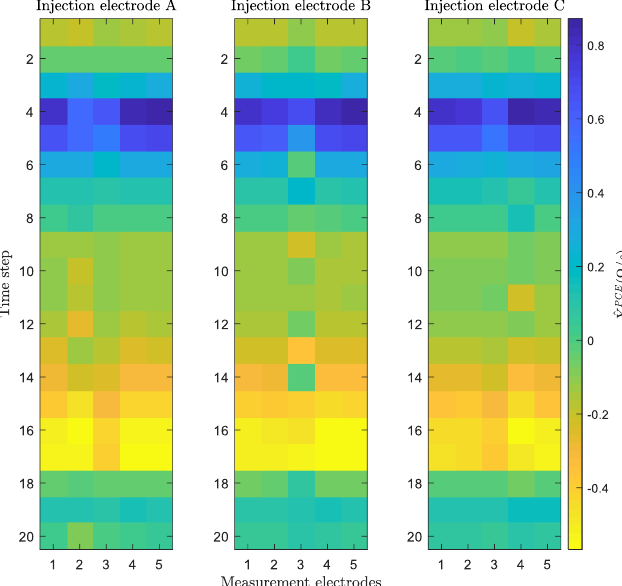
Fig.10: Values of 𝑌̂ 𝑛,𝑚𝑃𝐶𝐸 (𝑡) reflecting the discrepancy between the healthy and dissected conditions for 20-time steps and all proposed electrode combinations.